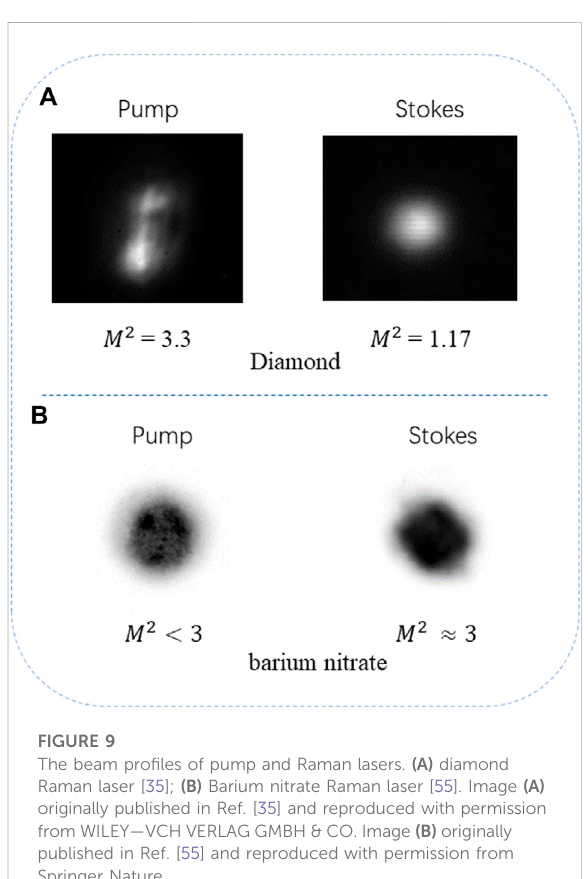
FIGURE 9 The beam pro fi les of pump and Raman lasers. (A) diamond Raman laser [35]; (B) Barium nitrate Raman laser [55]. Image (A) originally published in Ref. [35] and reproduced with permission from WILEY — VCH VERLAG GMBH & CO. Image (B) originally published in Ref. [55] and reproduced with permission from Springer Nature.